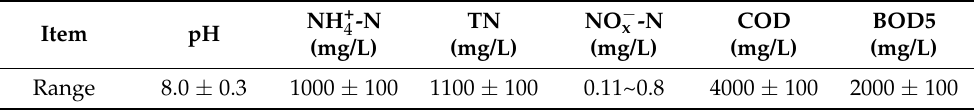
Table 2. The characteristics of the